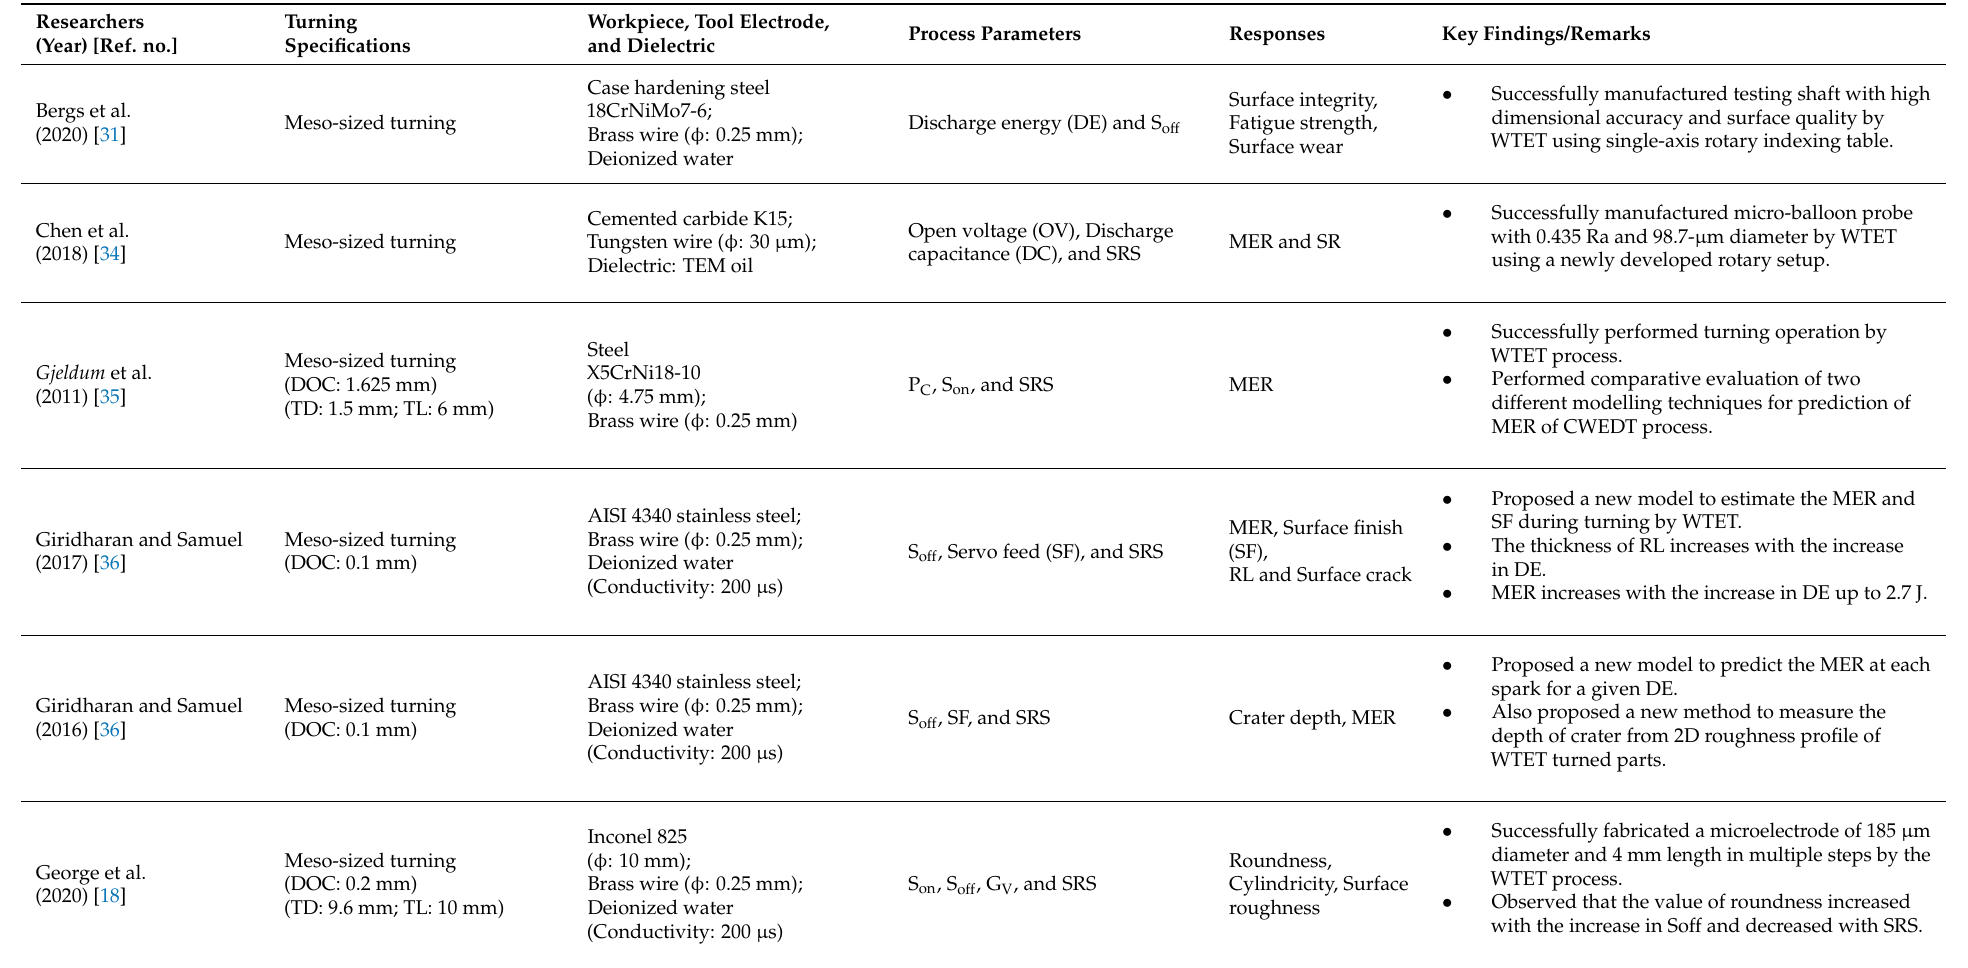
Table A2. Summary of the previous work on the fabrication of cylindrical and rotating parts by WTET